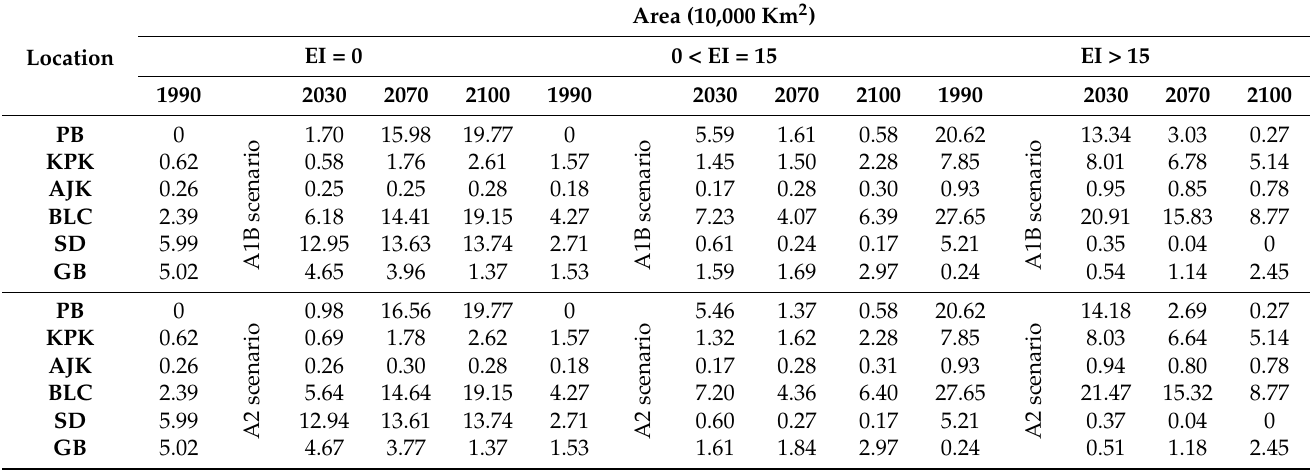
Table 2. Administrative area-wise land area percentage of Aelosthes sarta within the three ecoclimatic index ranges under the historic and future climatic conditions under A1B and A2 scenarios.